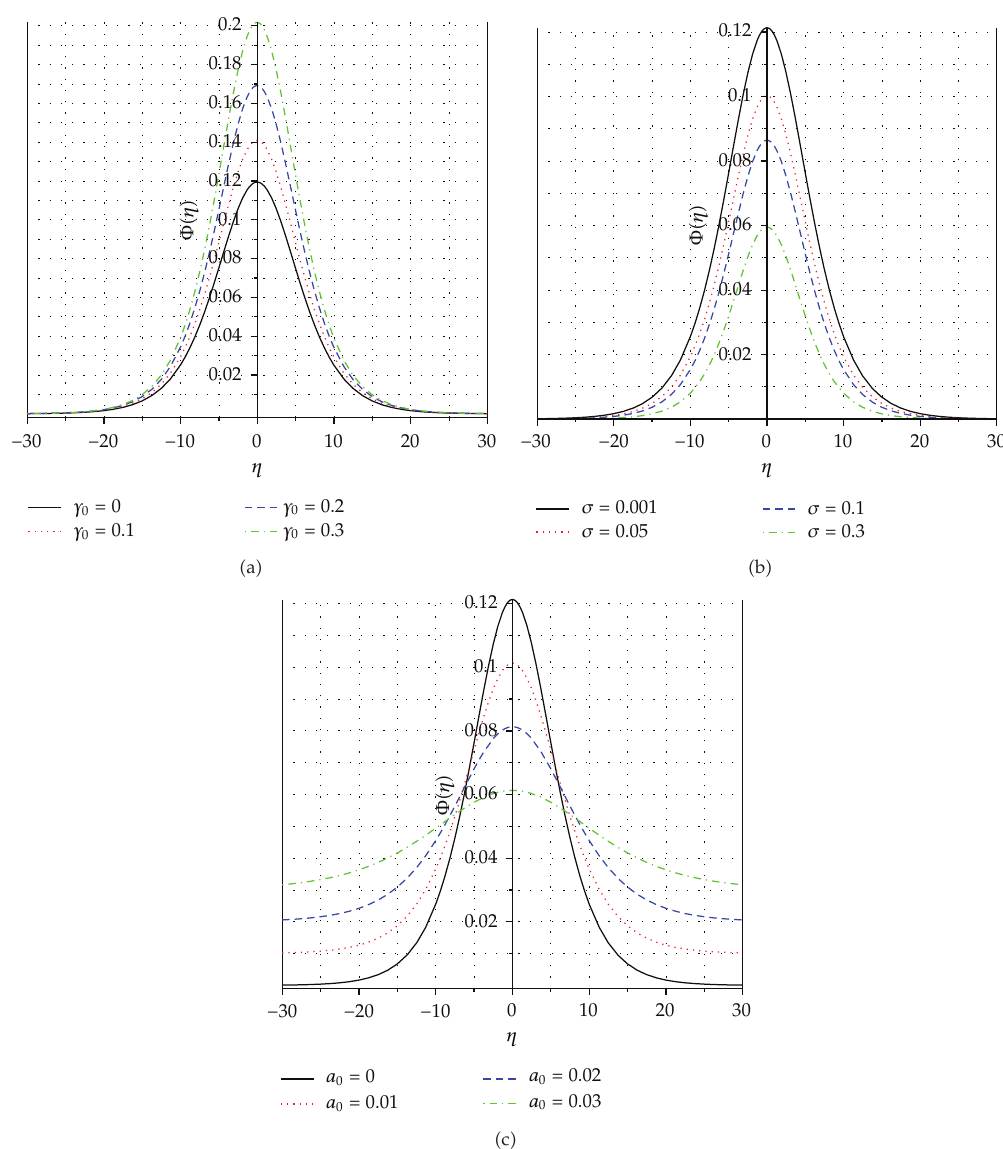
Figure 1: Profile of localized pulses for expression (cid:2) 4.3 (cid:3)